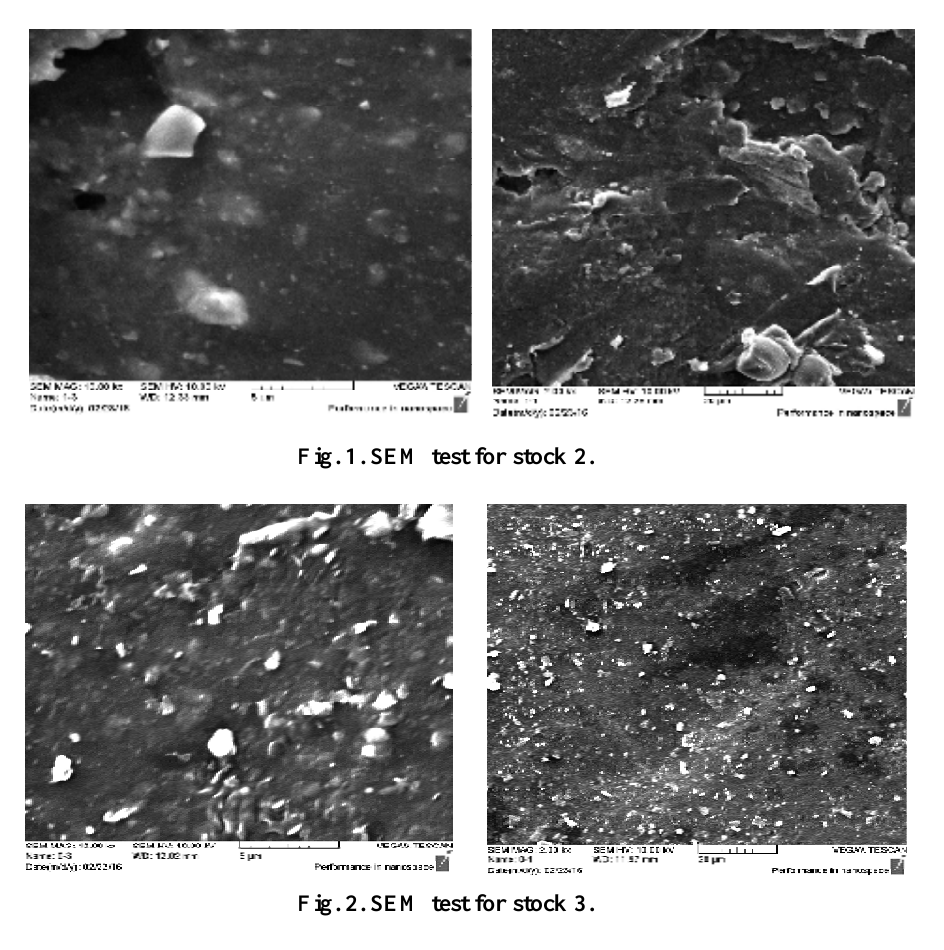
Fig. 2. SEM test for stock